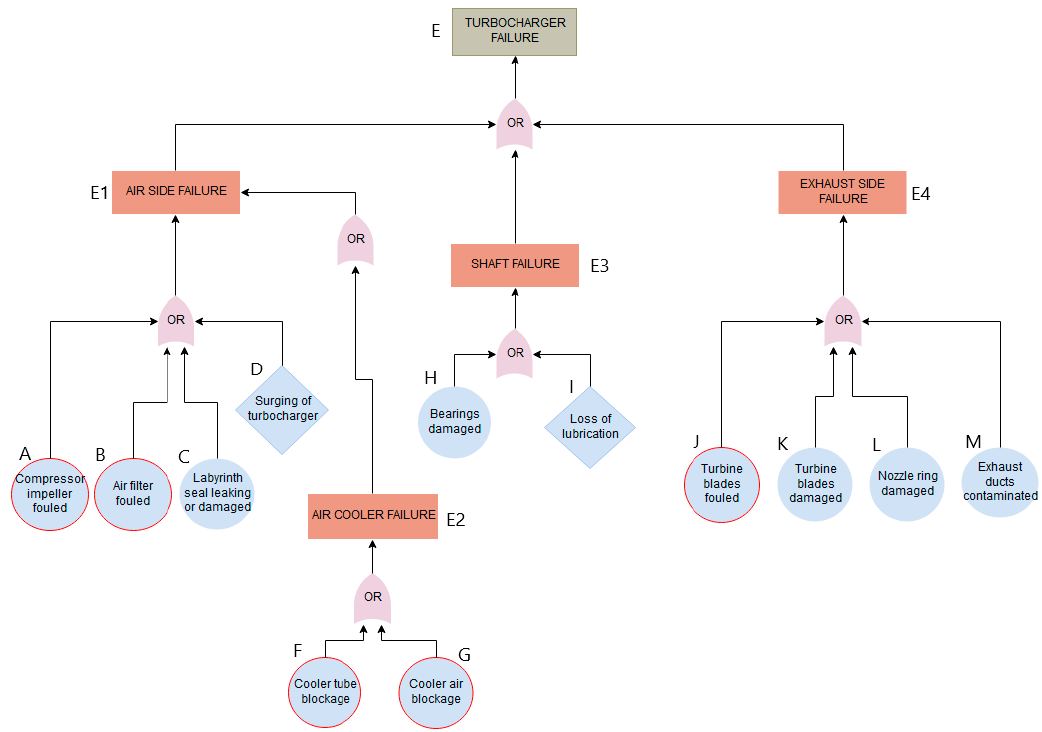
Figure 2. The fault tree of the turbocharger system .